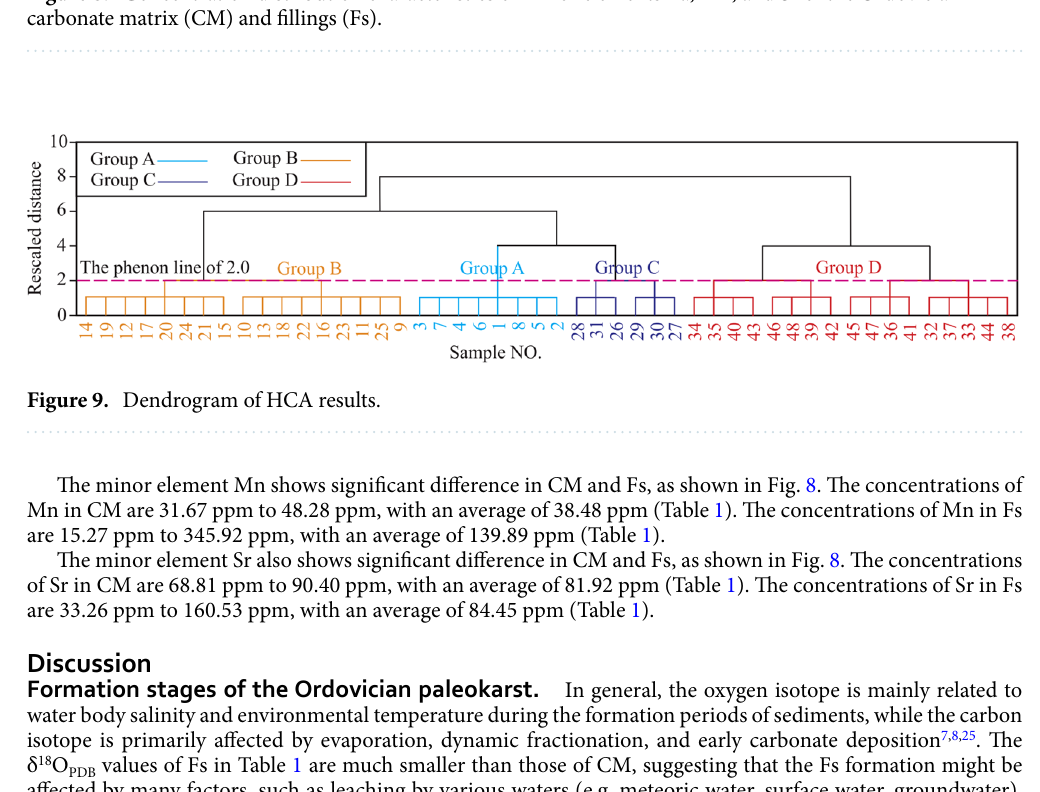
Figure 8. Concentration distribution characteristics of minor elements Ba, Mn, and Sr of the Ordovician carbonate matrix (CM) and fillings (Fs).